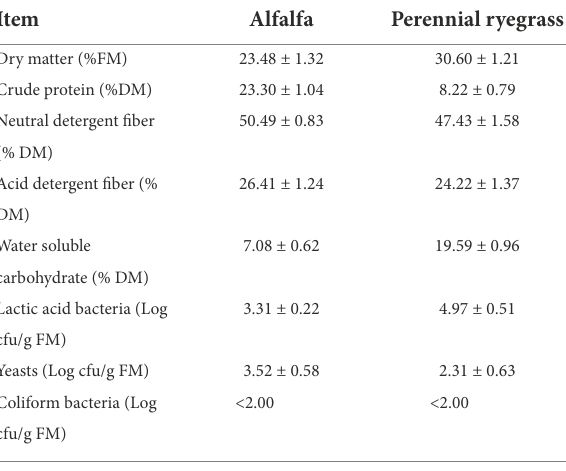
TABLE 1 Chemical compositions and microbial numbers of alfalfa and perennial ryegrass prior to